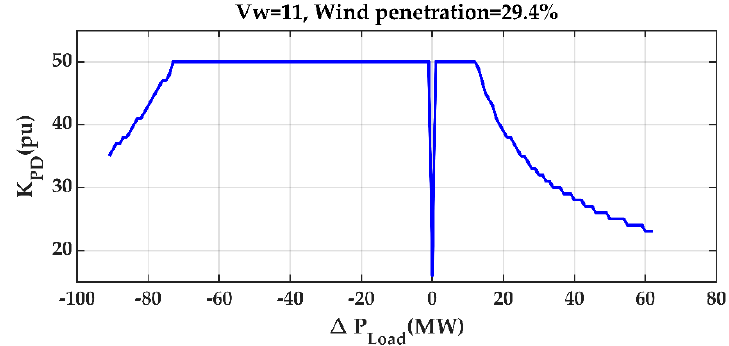
Figure 4. Optimal gain K PD as a function of the load disturbance ∆ P Load (wind penetration = 29.4% and V W = 11 m/s).